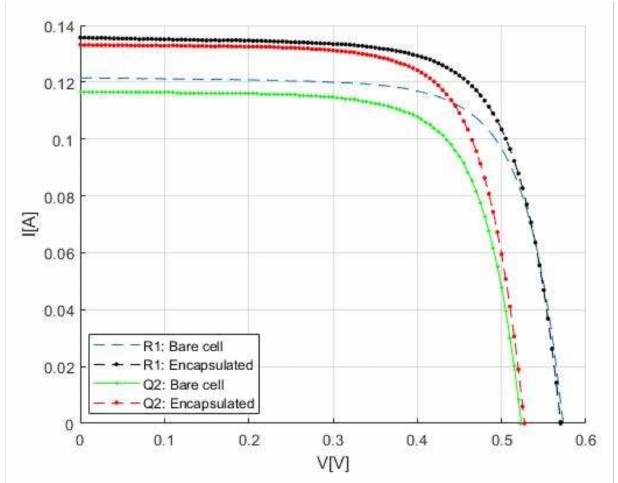
Figure 6. I-V characteristic for coated Q2 sample (with PA Si-QDs) and reference R1 sample with incident simulated solar light passing through a blue bandpass filter. The before coating (bare cell) and after encapsulation (and coating for Q2) curves are displayed.